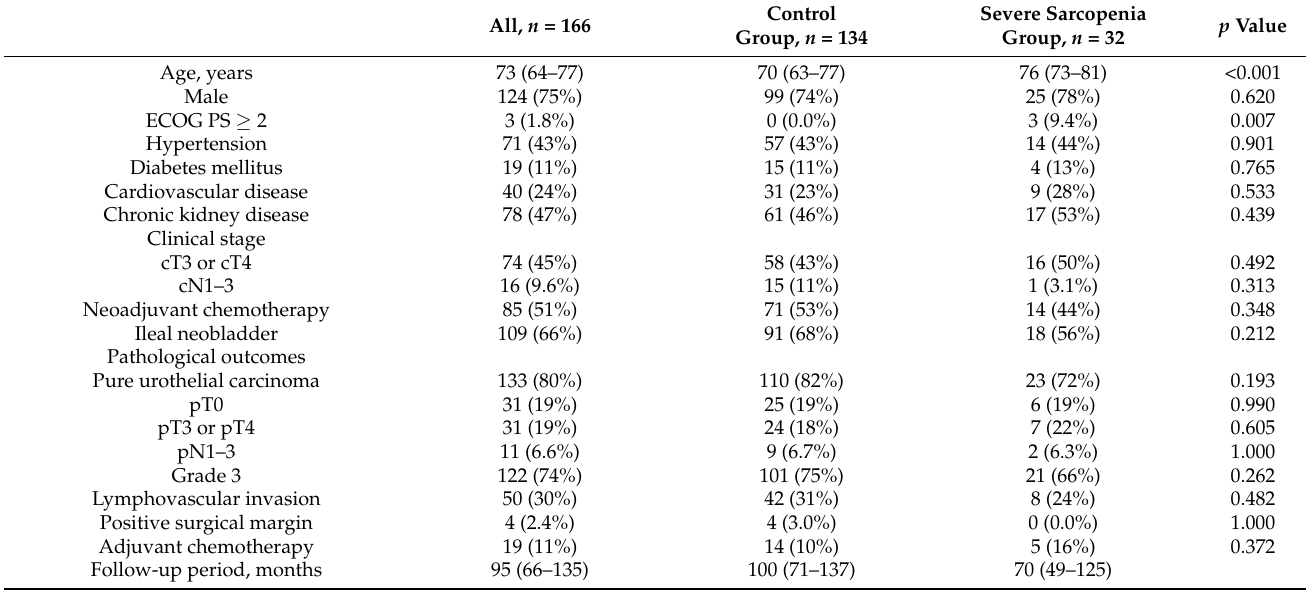
Table 1. Patients’